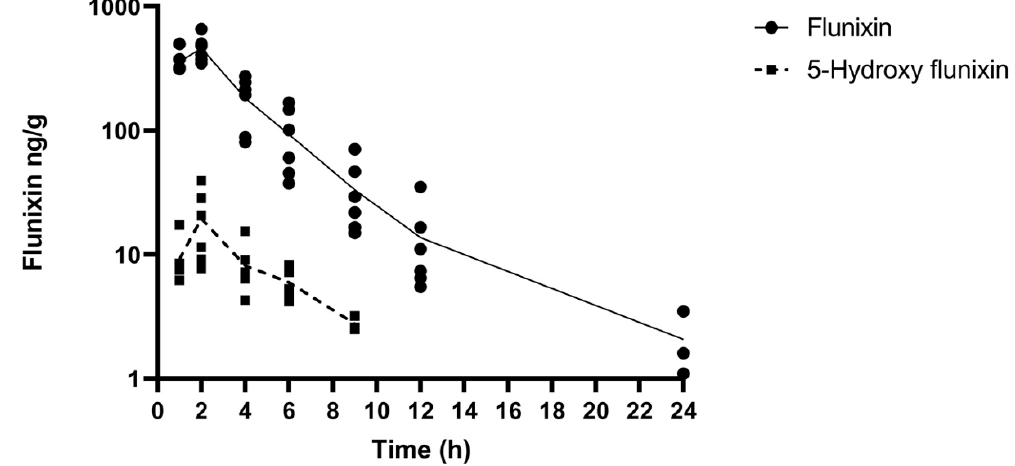
Figure 4. Mean ± SEM parent drug and metabolite concentration in tissue after administration of a single dose of flunixin (2.2 mg/kg) intramuscularly (n = 6) from 0 to 24 h post-administration in